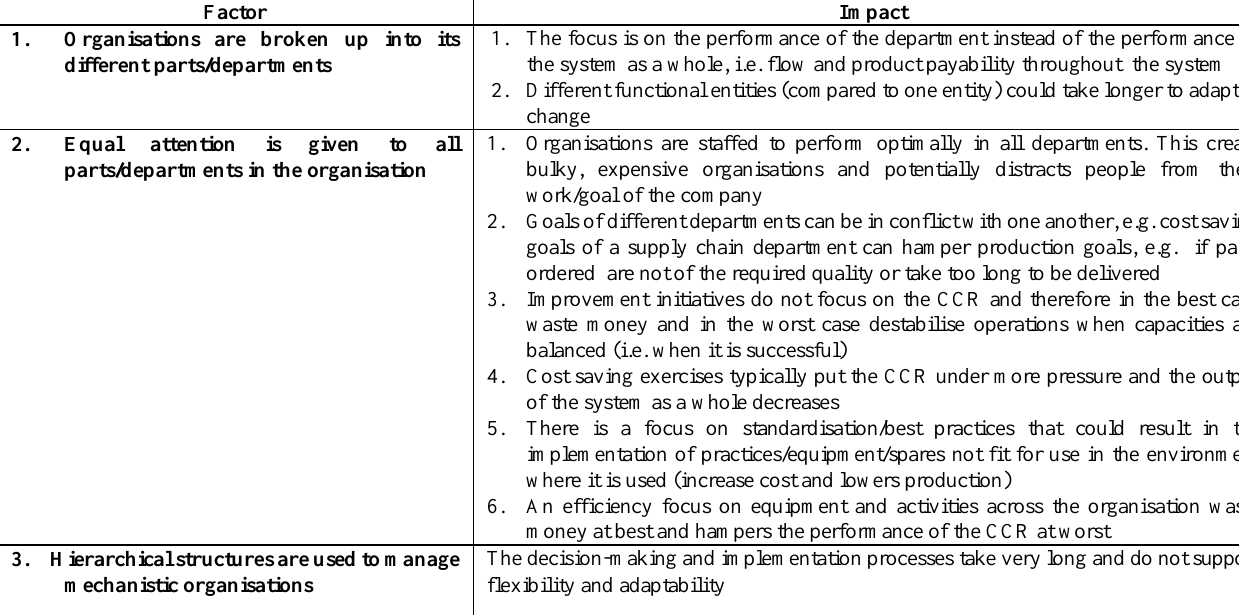
Table 2: Factors that contribute towards poor performance of mechanistic structures in complex mining